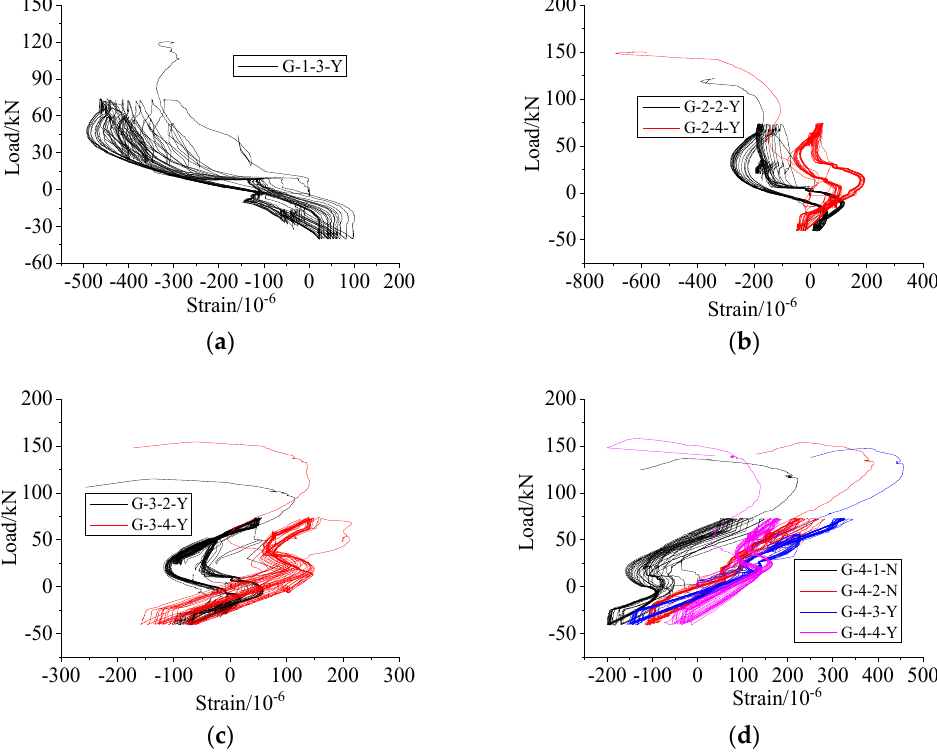
Figure 21. Load–longitudinal strain curves for the middle section of the sleeve near the steel bar under repeated high-stress tension and compression loading (SZ3). ( a ) Group G − 1, ( b ) Group G − 2, ( c ) Group G − 3, ( d ) Group G − 4.